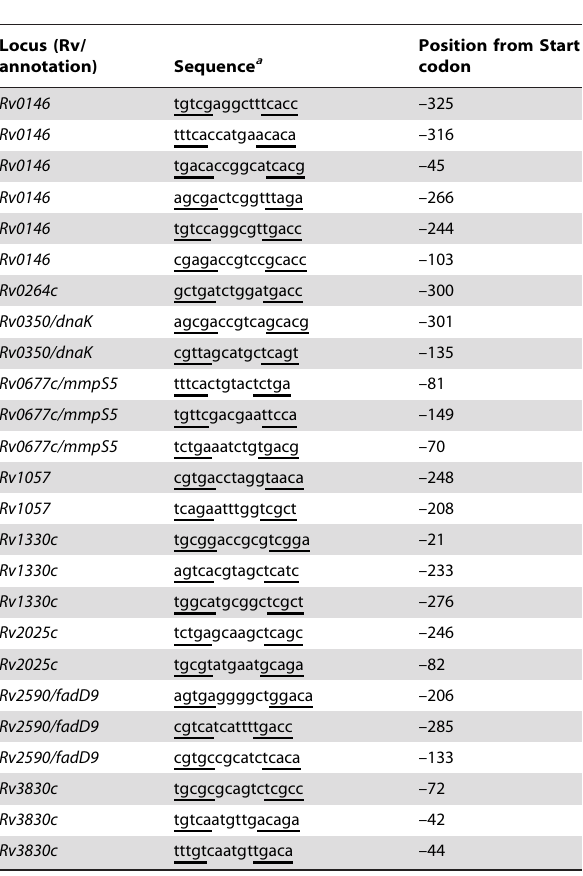
Table 2. Analysis of putative CRP-recognition sequences in 5’-UTRs of cAMP-regulon of